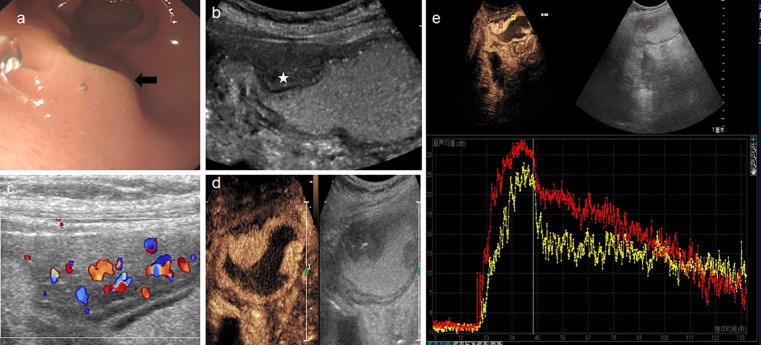
A 59-year-old woman with an inflammatory mass.a: Gastro-endoscope detected a bump with intact overlying mucosa protruding into the cavity. b: Conventional trans-abdominal ultrasound with oral contrast agent showed a well-defined hypoechoic lesion (star), with an intact mucosa. c: multiple vessels were visible on the color Doppler. d: DCUS showed a homogeneous hyper-enhanced mass in the antrum. e: Time-intensity curve depicted the lesion (red line) have higher PI than surrounding normal tissue (yellow).